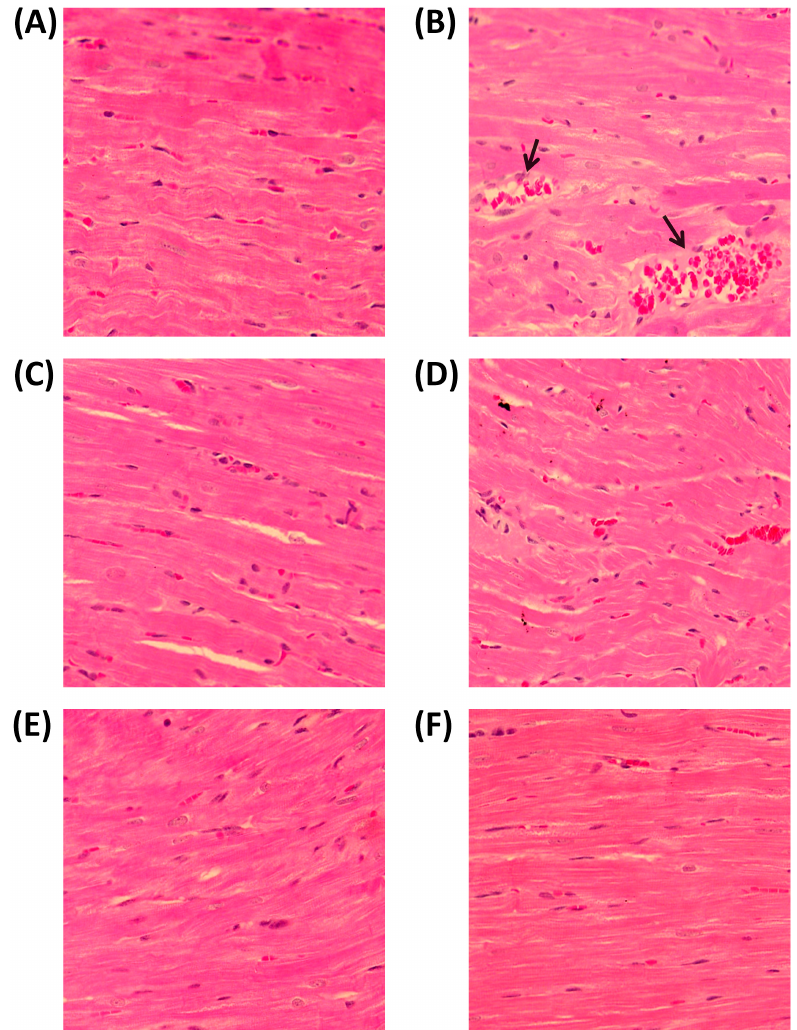
Figure 7. ( A ) Normal control group sections appeared as normal cardiac muscle tissues. ( B ) Hypercholesterinemia revealed focal myocardial stiffening and disarranging, vessel congestion and severe intermuscular inflammatory cell filtration as indicated by the arrow. ( C ) The QT-treated group revealed the appearance of recovered cardiac muscles with mild intermuscular blood congestion. ( D ) The LT-treated group showed cardiac muscles with mild inflammatory cell filtration and mild bleeding. ( E ) The QT and LT combined treatment group did not show any significant changes and had almost normal cardiac tissues. ( F ) AVTT treatment also showed insignificant changes in cardiac tissues, mostly remaining as normal.